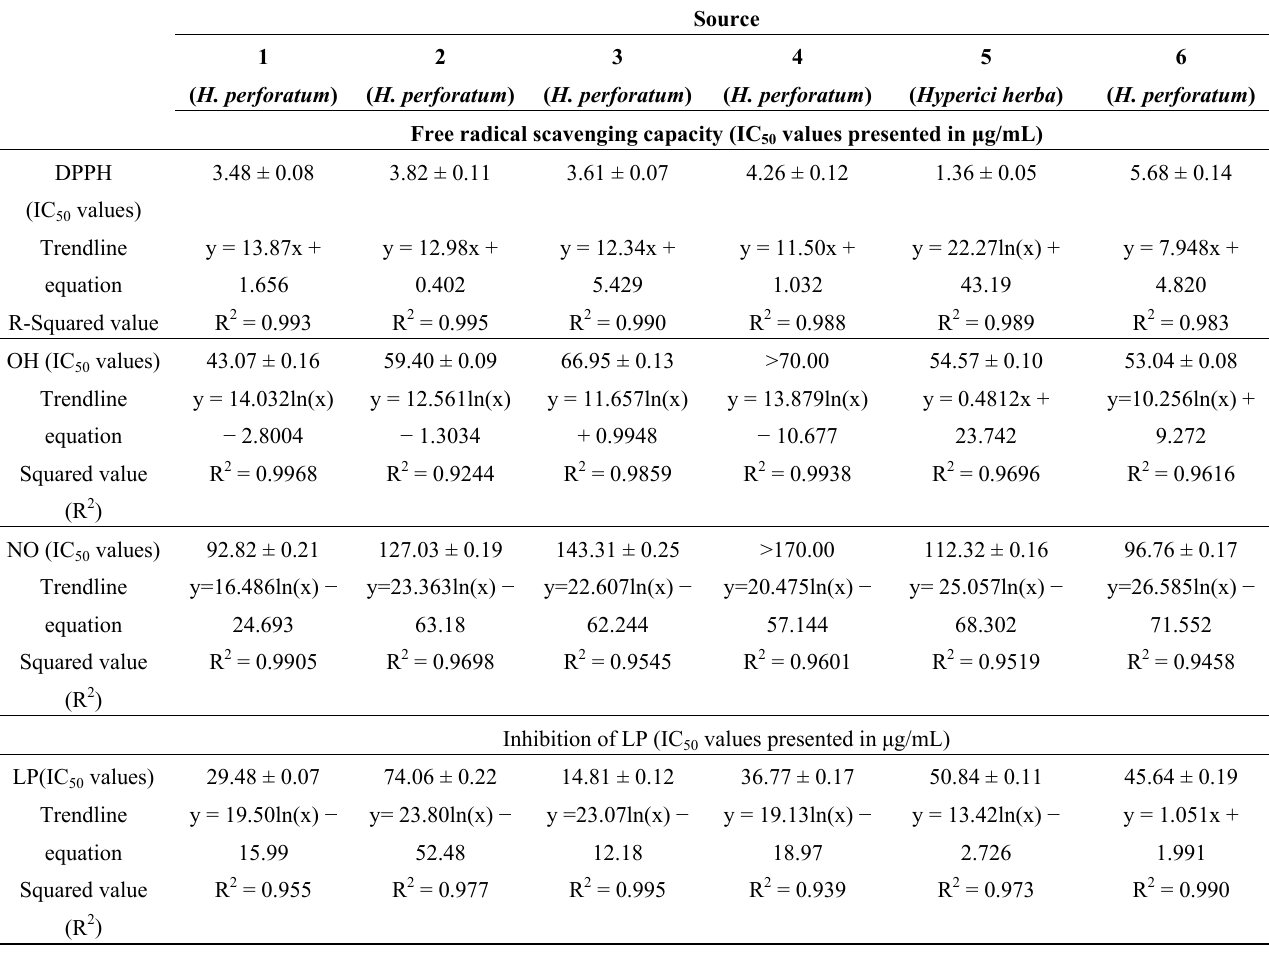
Table 3. Antioxidant potential of examined H. perforatum and Hyperici herba extracts.